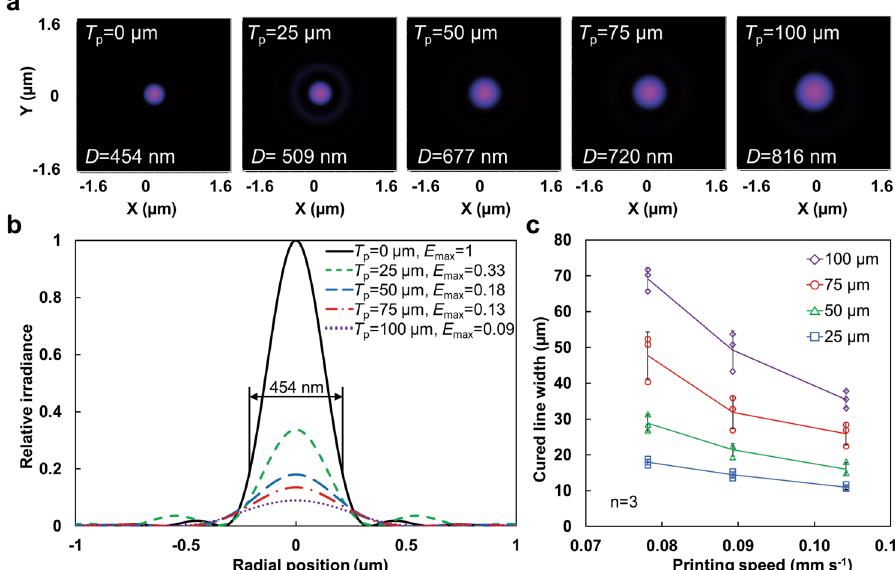
Fig. 3 Effect of photopolymer thickness on cured line width obtained from optical simulation software and experimentally validated. a Laser focal spot simulated in Zemax OpticStudio 20.1 at photopolymer thicknesses, T p , of 0, 25, 50, 75, and 100 µ m, with spot diameters, D , of 454, 509, 677, 720, and 816 nm, respectively. b Laser focal spot energy Gaussian distribution and maximum irradiance, E max , at various photopolymer thicknesses. c Printing results illustrating the relation between the cured line width and printing speed at various photopolymer thicknesses ( n represents sample size, while error bars represent one standard deviation).